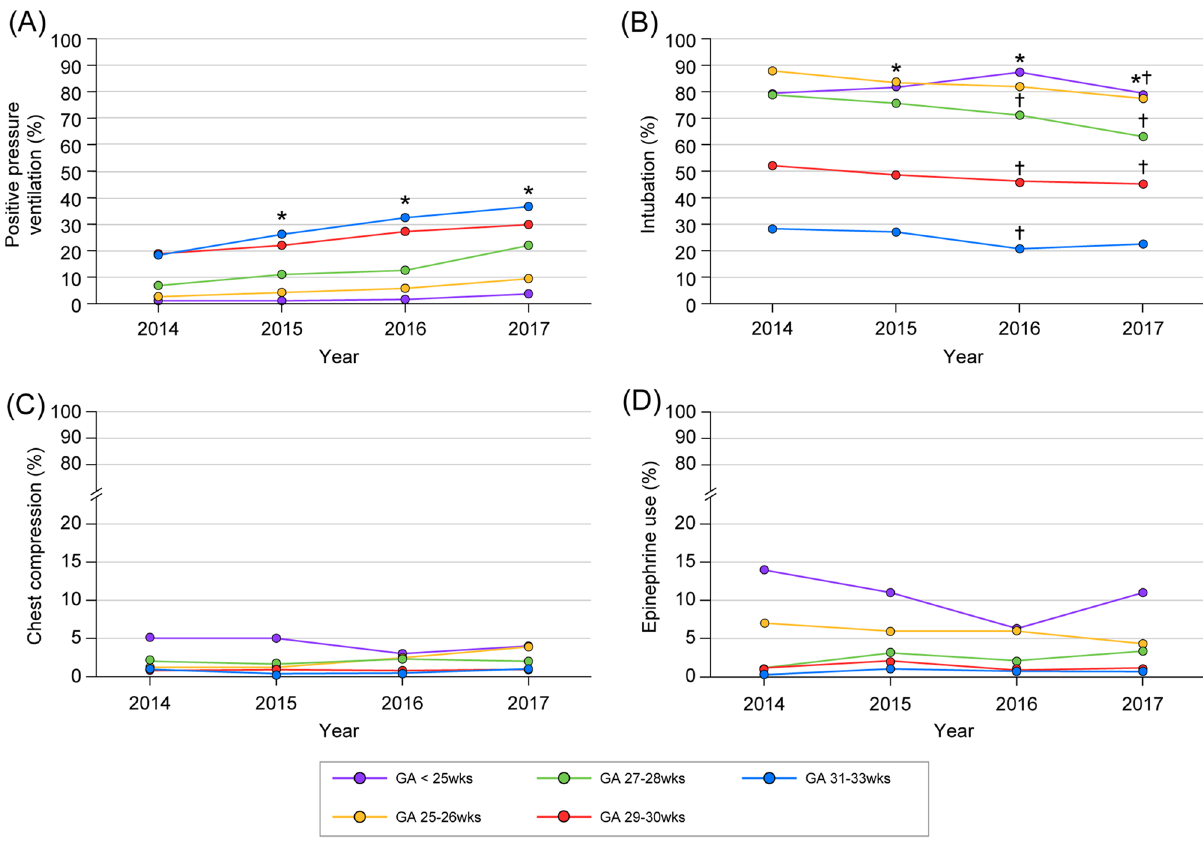
Figure 2. Trends in the highest level of resuscitation in the delivery room stratified by gestational age. The graph shows (A) positive pressure ventilation, (B) intubation, (C) chest compressions, and (D) epinephrine use in VLBWI with GA < 25 weeks (purple), 25–26 weeks (yellow), 27–28 weeks (green), 29–30 weeks (red), and 31–33 weeks (blue). GA gestational age, wks weeks, VLBWI very-low-birth-weight infants. *P value < 0.05, compared with rate in 2014. † P value < 0.05, compared with rate in 2014, by GA subgroup